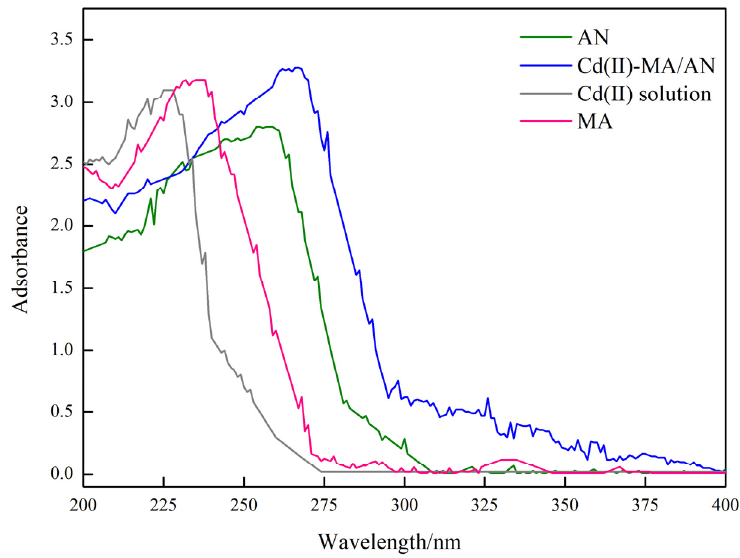
Figure 1. UV–vis adsorption spectra of Cd(II) solution, MA, AN and Cd(II)–MA/AN complex.